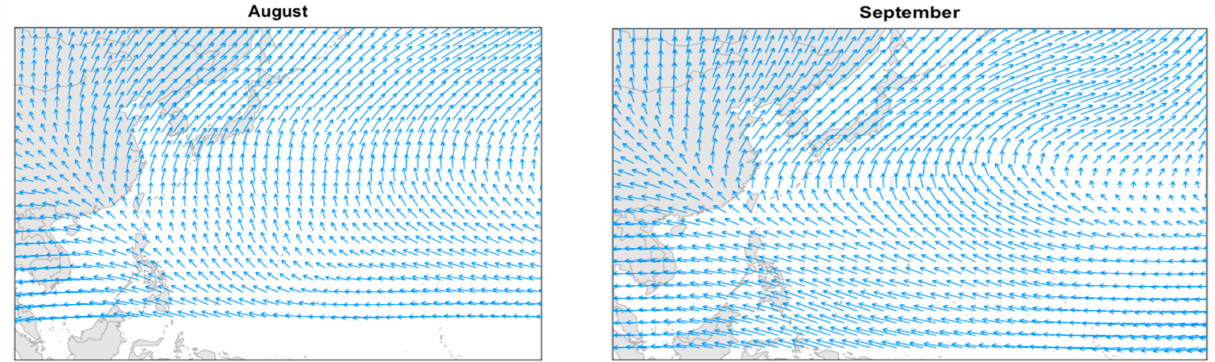
Figure 4. Modeled typhoon track velocity of WNP region in June–September. Simulations of typhoon genesis (Figure 5) and tracks (Figure 6) indicate how the modeled storms tend to move. In June–July, the typhoon track indicates a westward or northward movement and in the August–September season, it shows a tendency to move towards the north, and then recurve towards the northeast. It is clear that typical changes in TC activity were due to ENSO variability. This includes north-westward displacement of TCs in the WNP during La Niña (e.g., Chan [43,44]).